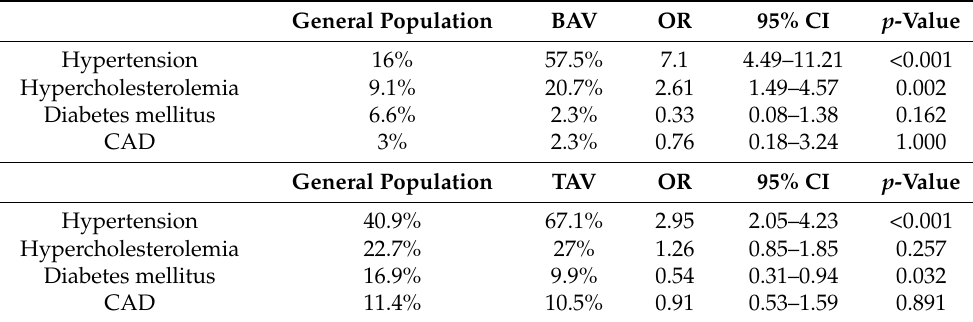
Table 3. BAV and TAV patients vs. general